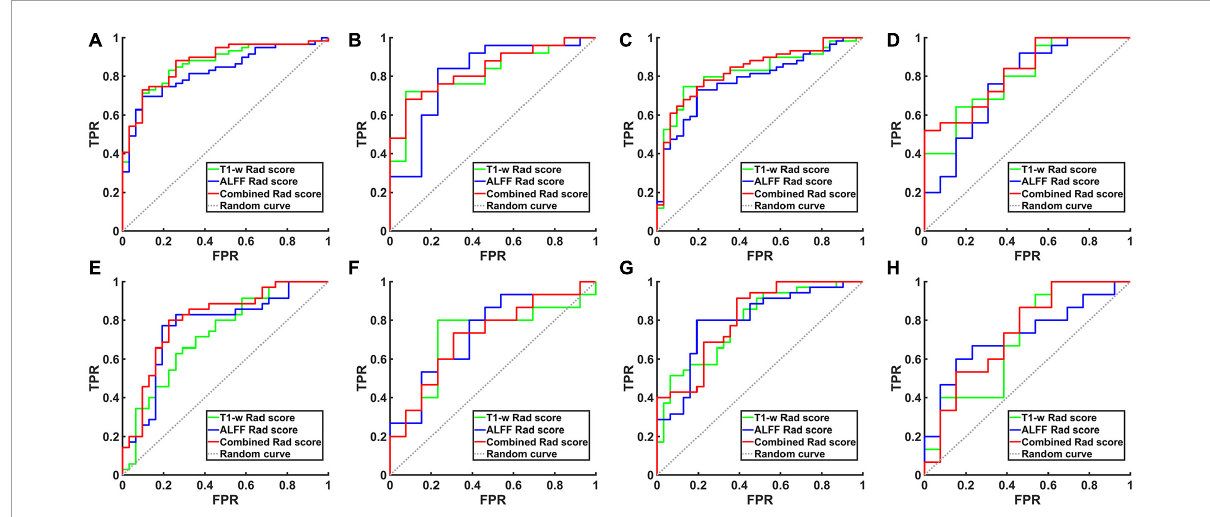
FIGURE2 The ROC curve of the hippocampal structural image, hippocampal ALFF in slow-5 frequency band and their combined model. (A) ROC curves for AD and NCs in the training set based on left hippocampal images. (B) ROC curves for aMCI and NCs in the training set based on left hippocampal images. (C) ROC curves for AD and NCs in the training set based on right hippocampal images. (D) ROC curves for aMCI and NCs in the training set based on right hippocampal images. (E) ROC curves for AD and NCs in the test set based on left hippocampal images. (F) ROC curves for aMCI and NCs in the test set based on left hippocampal images. (G) ROC curves for AD and NCs in the test set based on right hippocampal images. (H) ROC curves for aMCI and NCs in the test set based on right hippocampal images. TPR, true positive rate; FPR, false positive rate; AD, Alzheimer’s disease; aMCI, amnestic mild cognitive impairment; NCs, normal controls; ROC, receiver operating characteristic; ALFF, the amplitude of low frequency fluctuation.